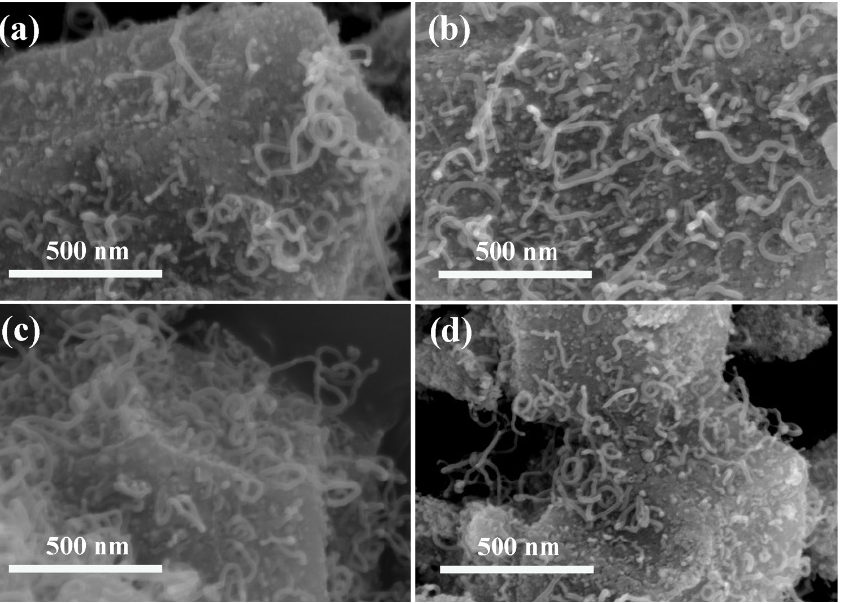
Figure 2. SEM images of ( a ) Co-NCNT-HPC600; ( b ) Co-NCNT-HPC700; ( c ) Co-NCNT-HPC800; ( d ) Co-NCNT-HPC900 at high magnification.